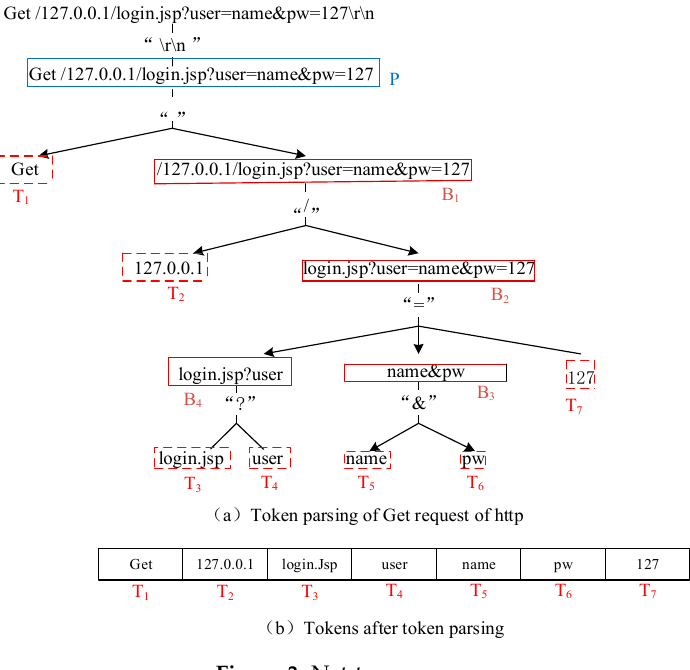
Figure 3. Net-trace